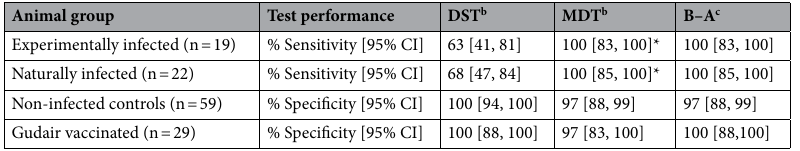
Table 3. IGRA a test results for DST and MDT reagents. * p < 0.05, McNemar’s test (compared to DST). a IGRA, interferon-gamma release assay using the BOVIGAM IFN-γ EIA kit. b DST (DIVA Skin Test) or MDT (Molecularly Defined Tuberculin) induced IFN-γ production. Cut-off for positivity = OD450 nm with MDT or DST minus nil antigen control > 0.1. c B–A, comparison of IFN-γ induced by stimulation with PPD-B and PPD- A. Cut-off for positivity = OD450 for PPD-B minus PPD-A >